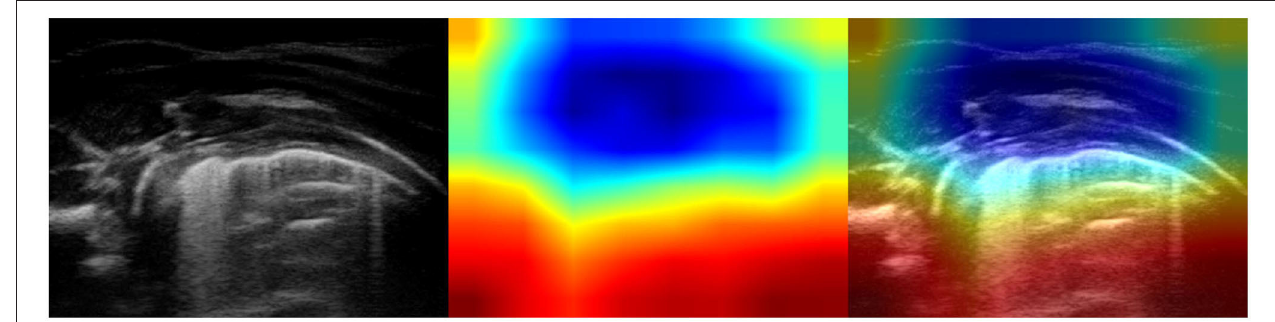
FIGURE 8 | Example of lung ultrasound image of a healthy lung incorrectly classified as bronchiolitis by the best performance model (Inception-v3). (Left) Original LUS image; (Middle) Class activation mapping produced by the Grad-CAM visualization; (Right) The class activation mapping overlaid transparently on the original LUS image. Note that red and orange regions correspond to high scores for the predicted class and highlight multiple, confluent long vertical artifacts. These visual features are typical of bronchiolitis but can also be observed in very young healthy infants ( ∼ 6 months of life). Therefore, the optimal model “mistake” results in the recognition of multiple long vertical